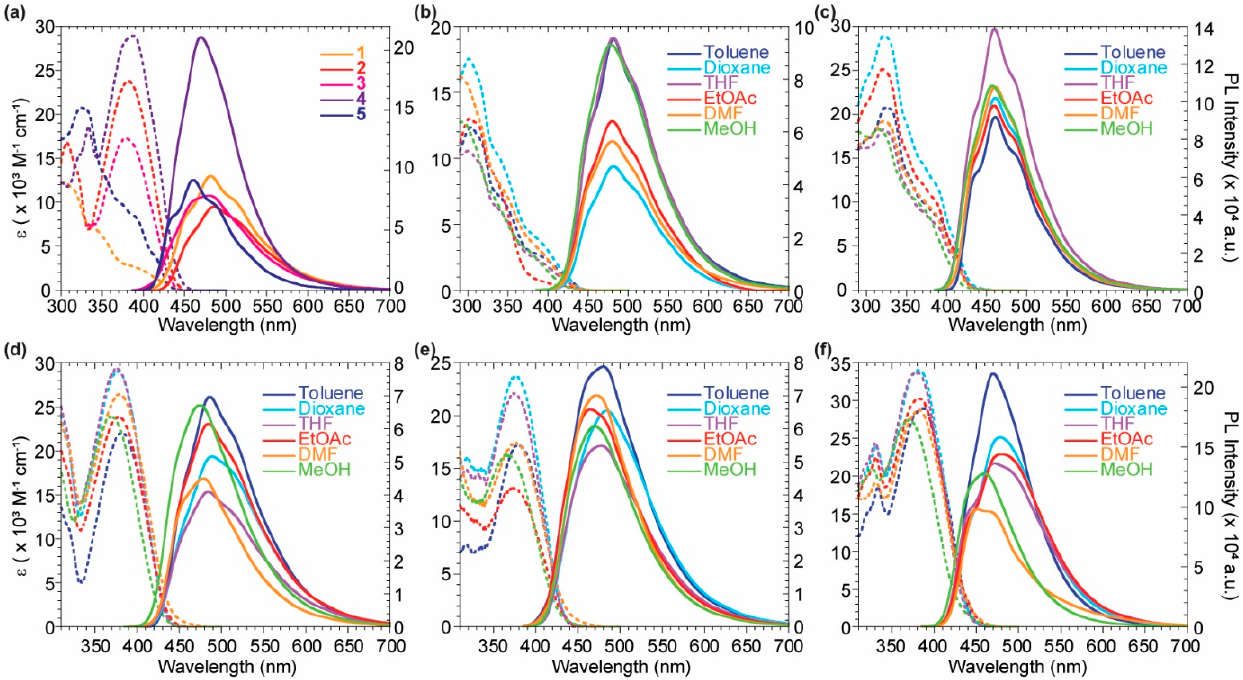
Figure 3. Photophysical properties of the reported probes 1 – 5 . ( a ) Absorption (dashed) and emission (solid) spectra of compounds 1 – 5 in toluene. ( b – f ) Absorption (dashed) and emission (solid) spectra in different solvents for compounds 1 ( b ), 5 ( c ), 2 ( d ), 3 ( e ), 4 ( f ). The emission spectra were normalized to 0.1 intensity at the excitation wavelengths. Table 1. Solvatochromic properties of probes 1 – 5 .